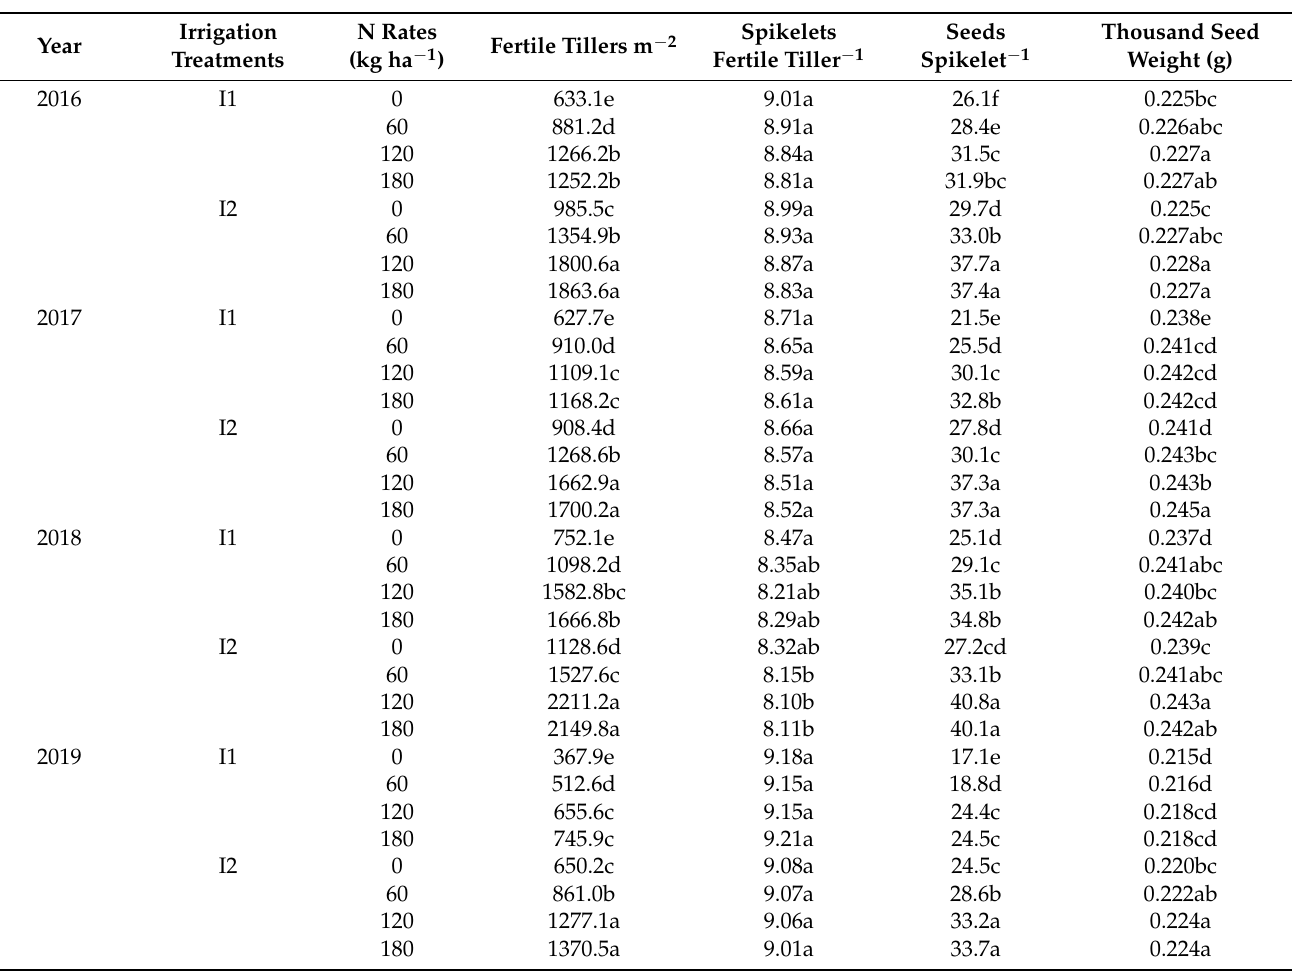
Table 2. Effects of different irrigation and N rate treatments on Cleistogenes songorica seed yield components from 2016 to 2019.